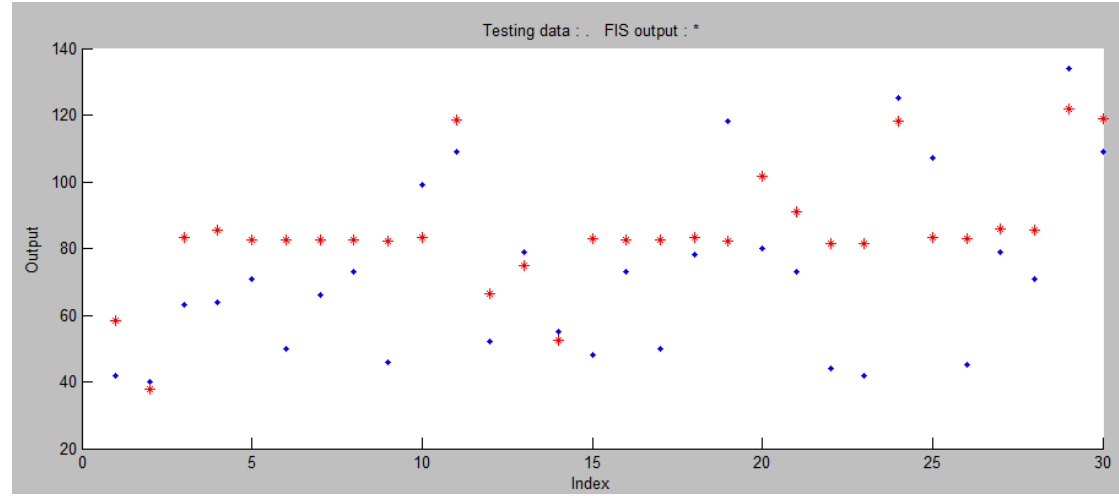
Figure 9. Deviations of the ANFIS model output from the measured testing data.